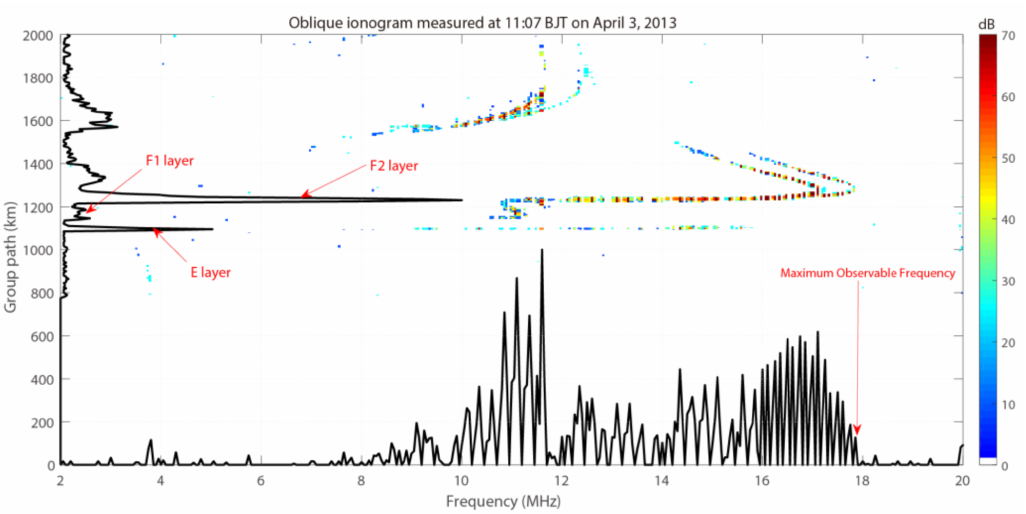
Figure 2. A typical oblique ionogram with projections at the group path and frequency recorded at 13:07 LT on 3 April 2013, between Beijing and Wuhan. The back lines on the vertical and horizontal axes, respectively, represent the projection values at the group path and